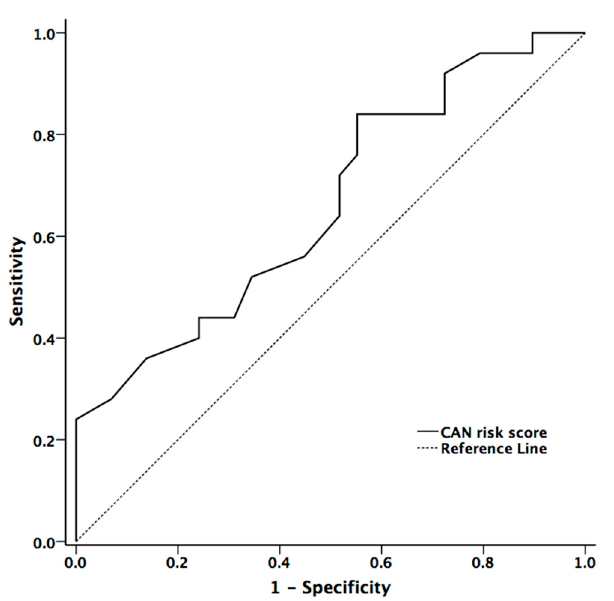
Figure 3. The receiver operator characteristic curve for CAN risk score for diagnostic accuracy for presence of cardiovascular autonomic neuropathy in patients with Parkinson’s disease (PD).